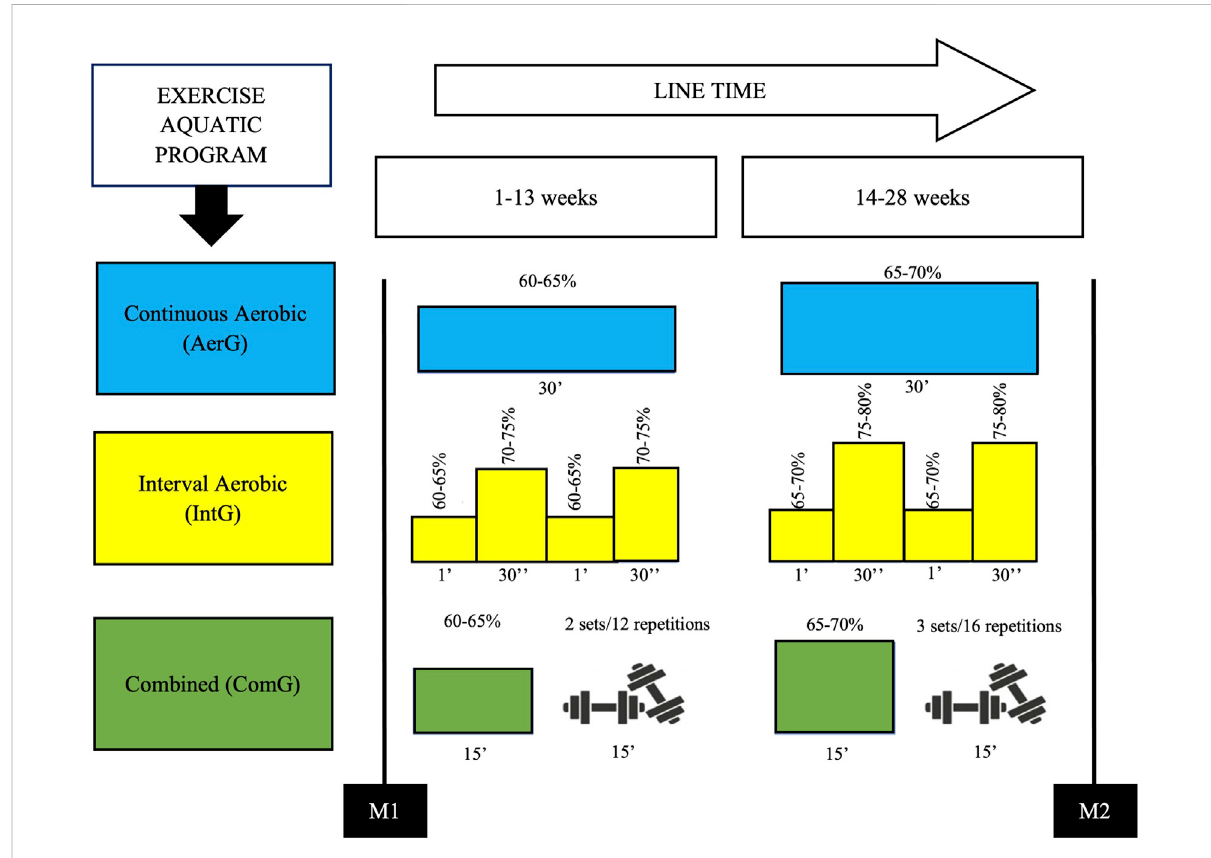
FIGURE 2 Time line, periodization and characterization of the exercise